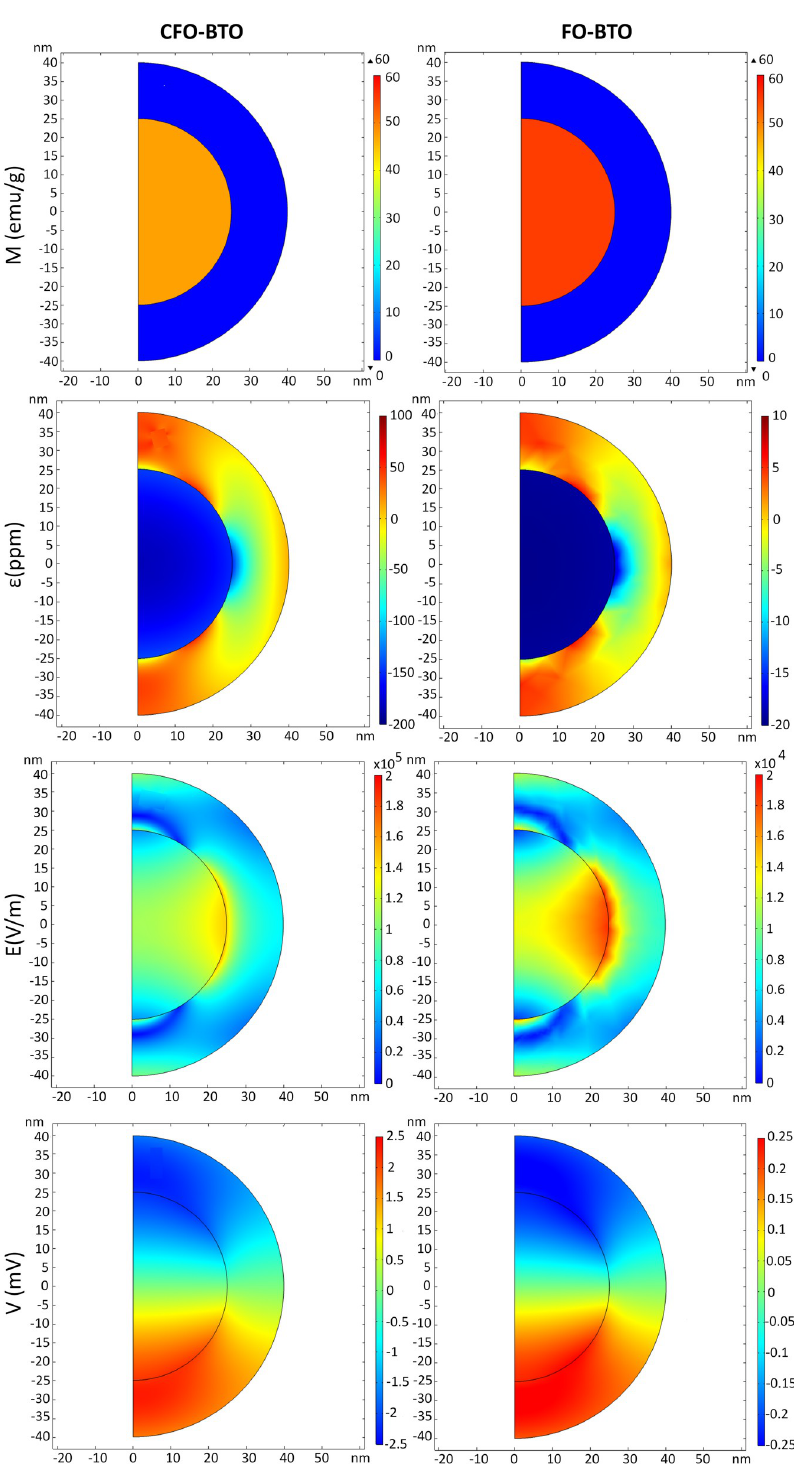
Fig 3. Magnetoelectric effect elicited by DC magnetic field stimulation. Distribution of (from top to bottom) surface: M (emu/g), strain ε (ppm), electric field E module (V/m), and electric potential V (mV) in 2D axisymmetric (left) CFO-BTO and (right) FO-BTO core shell nanoparticles ( Ø core = 50 nm and t shell = 15 nm) when a high amplitude (H = M s ) magnetic field is used as stimulation.